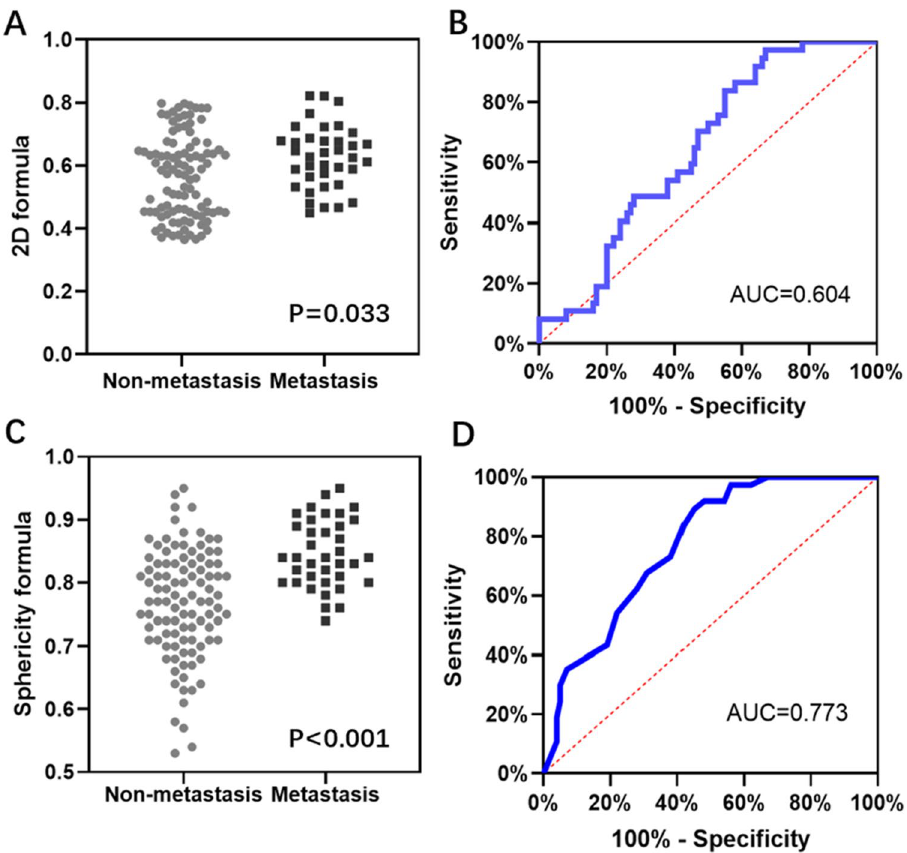
Figure 3. Evaluation of the diagnostic efficacy of the 2D formula and the sphericity formula. ( A ) and ( C ): Visualization of the values measured in 137 lymph nodes using the 2D formula( A ) and 3D formula( C ); ( B ) and ( D ): ROC curves for the diagnosis of lymph node metastases by the 2D formula ( B ) and the sphericity formula ( D